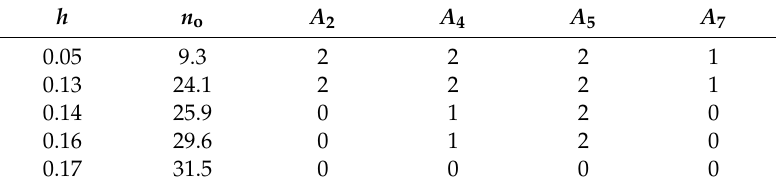
Table 7. Of an h value, number of observations ( n o ), and number of breakpoints detected in the trend components of A 2 , A 4 , A 5 , and A 7 of the time-series. h is the ratio of the number of observations within a segment divided by the total length of a time-series, excluding the beginning and end observations. h n o A 2 A 4 A